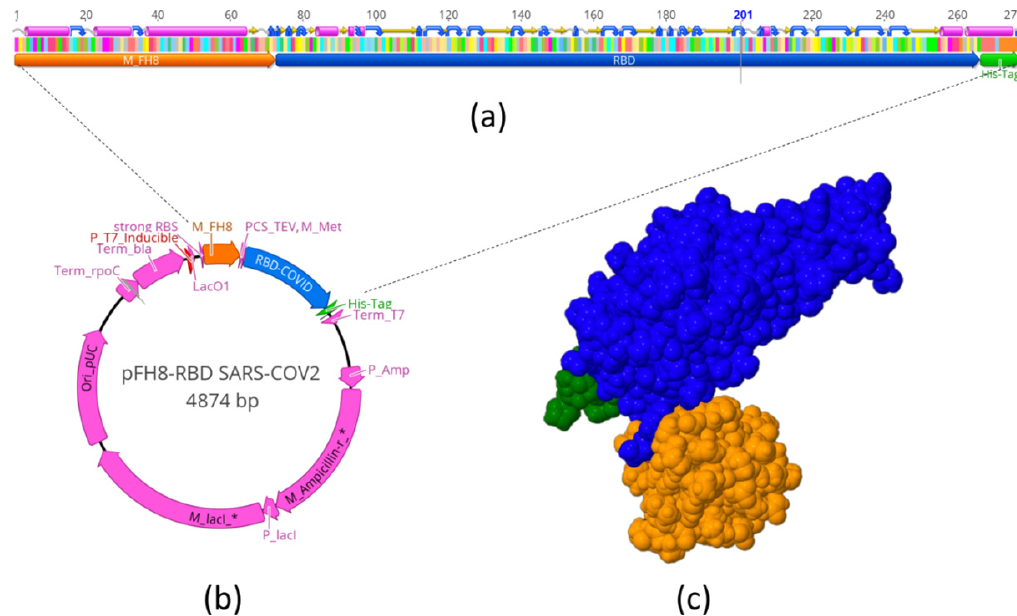
Figure 1 Figure 1. Expression of S-RBD N318-V510 in Escherichia coli . ( a ) Schematic representation of the sequence used to produce the MFH8-RBD Spike -HisTag protein (S-RBD N318-V510 ). This expression cassette was inserted into the ( b ) pFH-RBD SARS-CoV-2 plasmid for expression in E. coli. ( c ) Molecular 3D structure of the S-RBD N318-V510 protein, as predicted by molecular structure